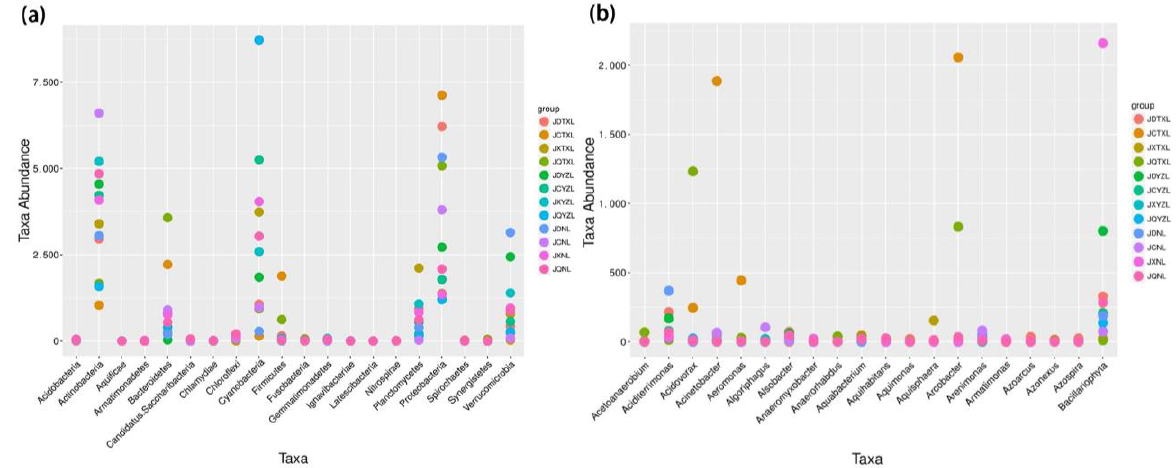
Figure 4. Obvious different abundance in bacterial taxa at phylum level ( a ) and genus level ( b ). The water samples in spring, summer, autumn, and winter, respectively, are denoted as JCTXL, JXTXL, JQTXL and JDTXL for Tangxun Lake; JCYZL, JXYZL, JQYZL and JDYZL for Yezhi Lake and JCNL, JXNL, JQNL and JDNL for Nan Lake.